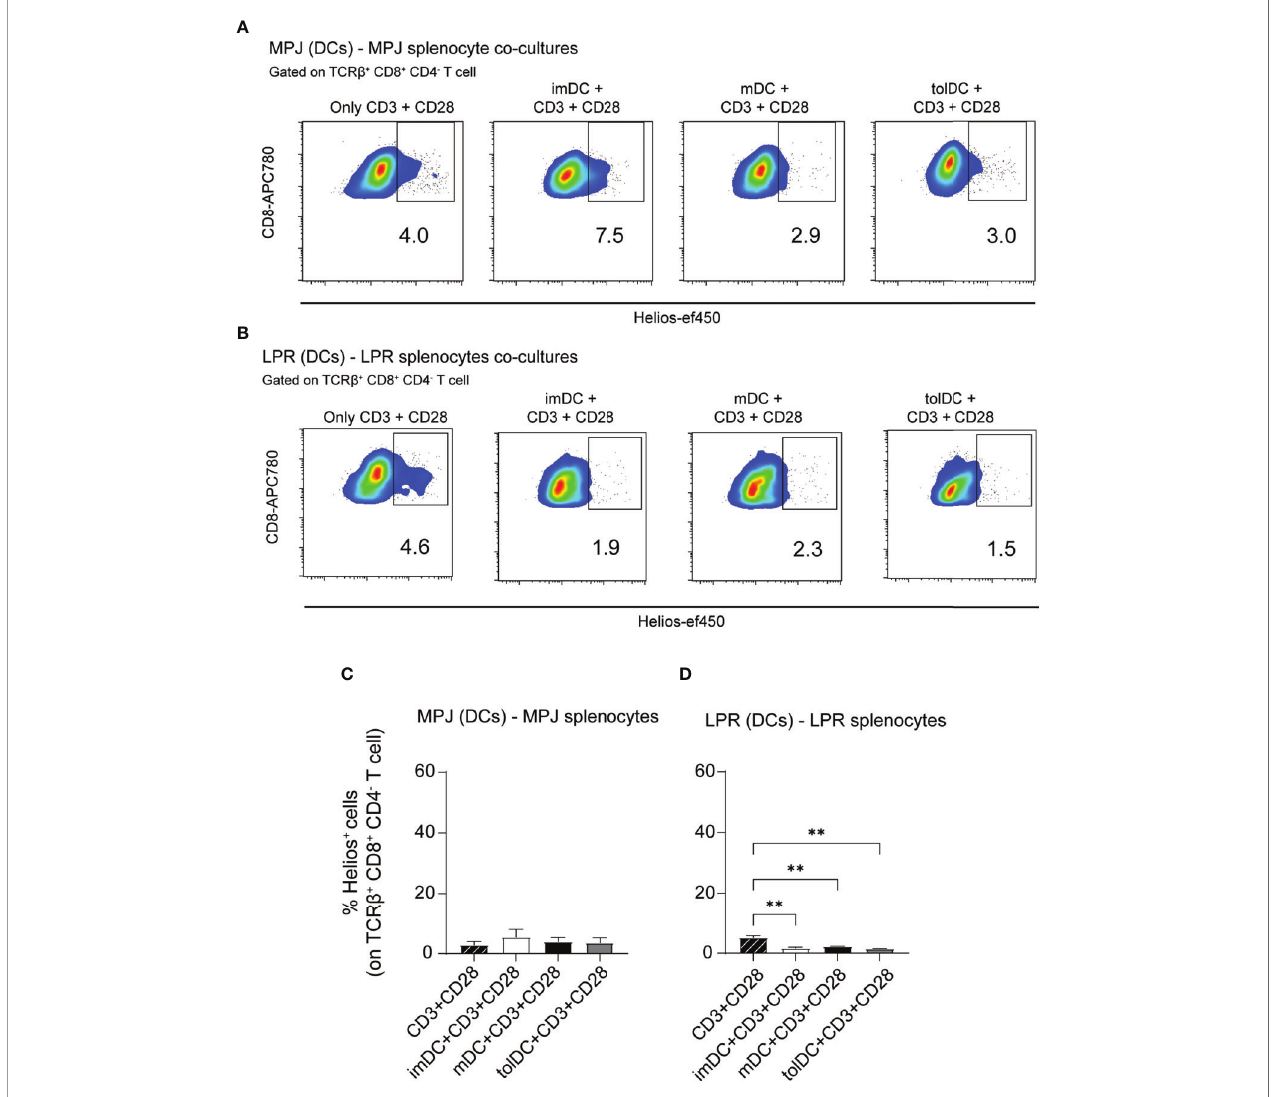
FIGURE 8 | Helios expression in CD8 + T cells from MRL mice co-cultured with different types of DCs. (A) Representative fl ow cytometry plots gated on TCR b + CD8 + CD4 − T cells showing Helios expression in a 3-day co-culture experiment with bone marrow derived dendritic cells (DCs) and splenocytes from MPJ mice in the presence of CD3 and CD28 stimuli. (B) Representative fl ow cytometry plots gated on TCR b + CD8 + CD4 − T cells showing Helios expression in 3-day co- culture experiments with bone marrow – derived DCs and splenocytes from LPR mice, in the presence of CD3 and CD28 stimuli. (C) Percentage of Helios + cells among MPJ TCR b + CD8 + CD4 − T cells. (D) Percentage of Helios + cells among LPR TCR b + CD8 + CD4 − T cells. The data represent the mean ± SD: **P < 0.01 by one- way ANOVA with a Tukey multi-comparison post-test (n = 2 – 4 independent